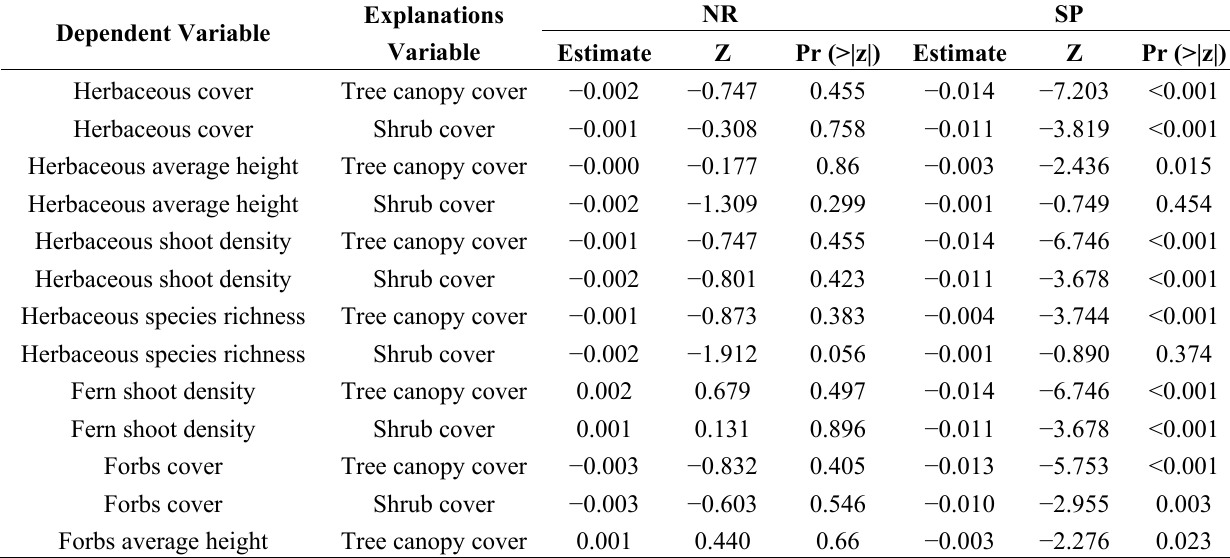
Table 4. Results of generalized linear mixed-effects models (GLMMs) for the effects on the understory herbaceous layer by covers of the tree canopy and shrub in the naturally regenerated forests (NR) and the reforested spruce forests (SP) on similar clear-cuts in the eastern Tibetan Plateau. Structure and species density of herbaceous layer were selected as dependent variables. Tree canopy and shrub cover were selected as explanation variables and stand as a random factor, with three plots nested in each stand, and nine quadrats nested in each plot. In both cases, Poisson error distributions with log-link function were selected in